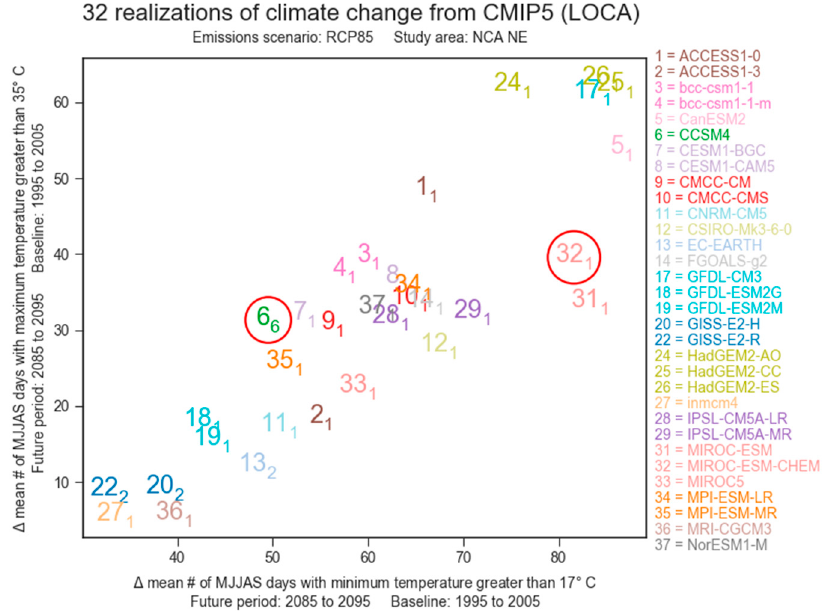
Figure 9. For the Northeast region, MIROC-ESM-CHEM does not fully capture the upper end of projected temperature changes.